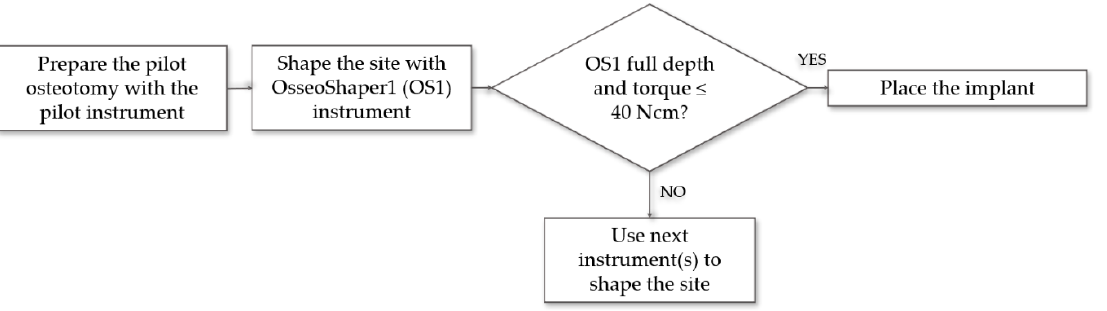
Figure 1. Simplified surgical procedure workflow.